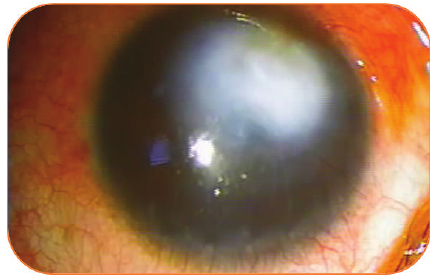
Figure 2: Evolution of neovascularization after 2 intrastromal injections of bevacizumab.